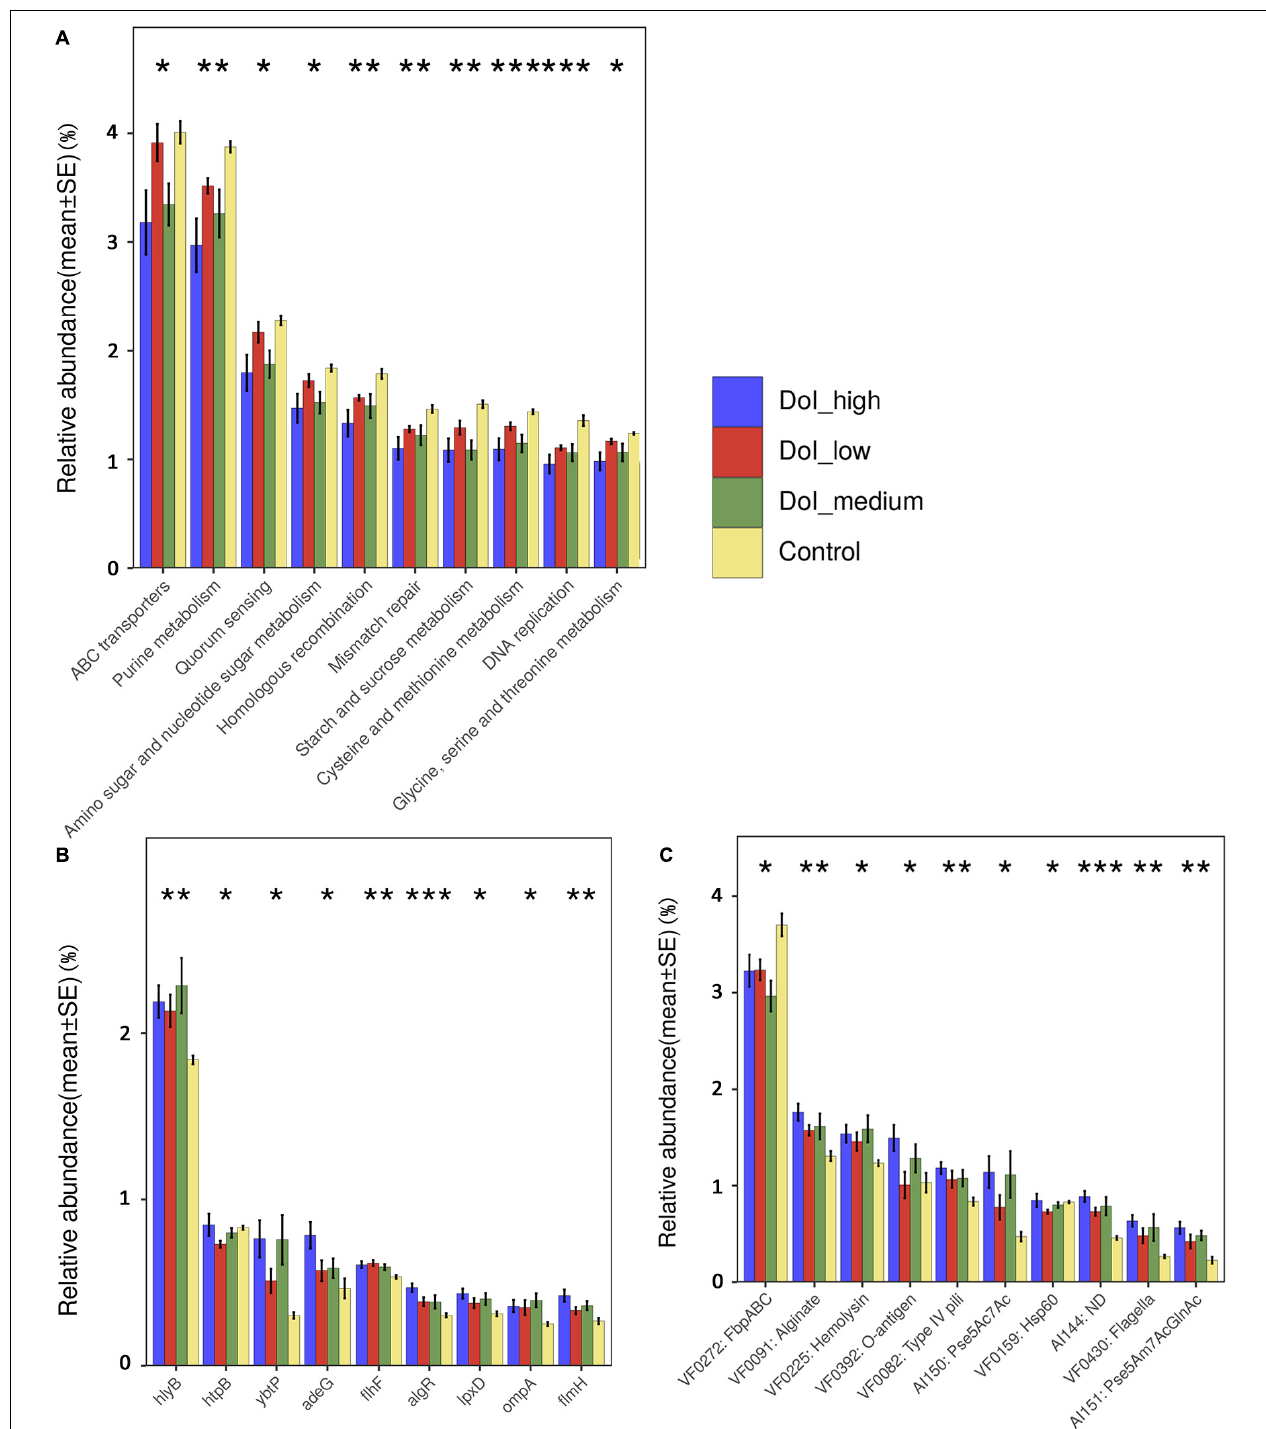
FIGURE 4 | Microbiome functional changes between groups. (A) The KEGG database counted the abundance of each knumber, found the knumber contained in the corresponding pathway, summed the abundances of all the knumbers contained in the pathway, and then normalized it to 100%. After that, finding the corresponding level 2 of the pathway, and calculating their separately relative abundance. KEGG pathways that significantly decreased as the disease progressed. (B,C) The VFDB database using mapped ORF in gene set calculated the abundance from the aspects of gene and VF number. It also added the abundance of genes or the same VF number, and then normalized it to 100%. Analysis of significant differences in virulence-related genes and virulence factors among the four groups. Some virulence factors had increased expression with tumor progression. (using Kruskal-Wallis non-parametric tests, * p < 0.05, ** p < 0.01, *** p <